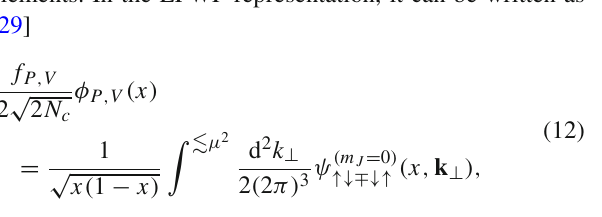
Fig. 1 Mass spectra of the four heavy-light meson systems, each with 12 low-lying states, using N max = L max = 32. Horizontal axis refers to the J P values of the states. The green dashed lines indicate the corre- sponding open flavor threshold. Blackboxes are the results of this work, indicating the highest and lowest mass from different m J ’s, while the dashed lines in between are the averages M . Red bars are the experi-